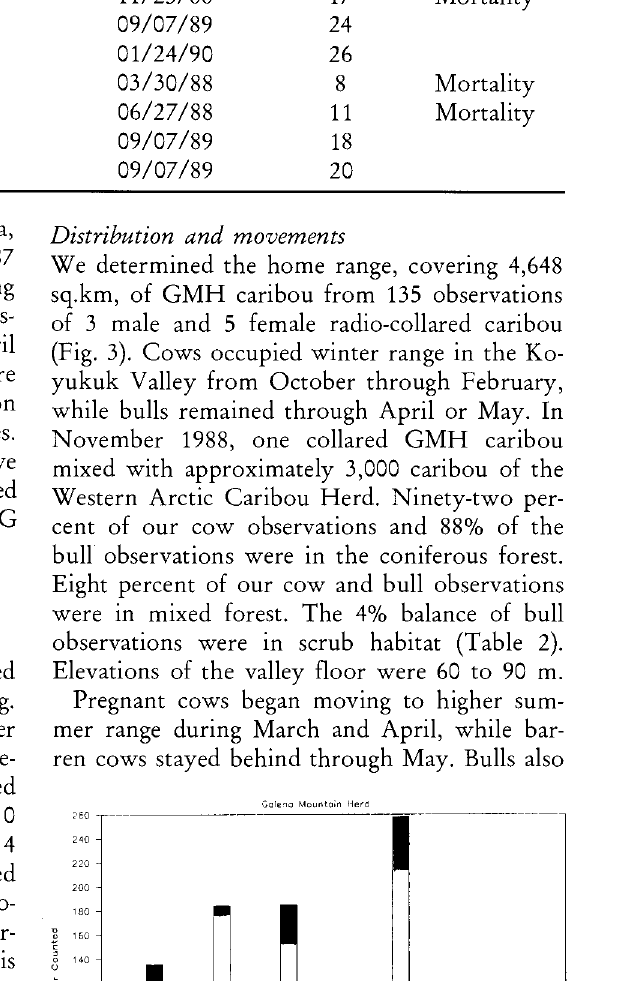
Fig. 2. Aerial counts of 1983-89. IZZI Adults H Calves (Caribou were difficult to track and locate du ring October 1986 and 1988. Animals were neither sexed nor aged during surveys conduc ted June 1988 and